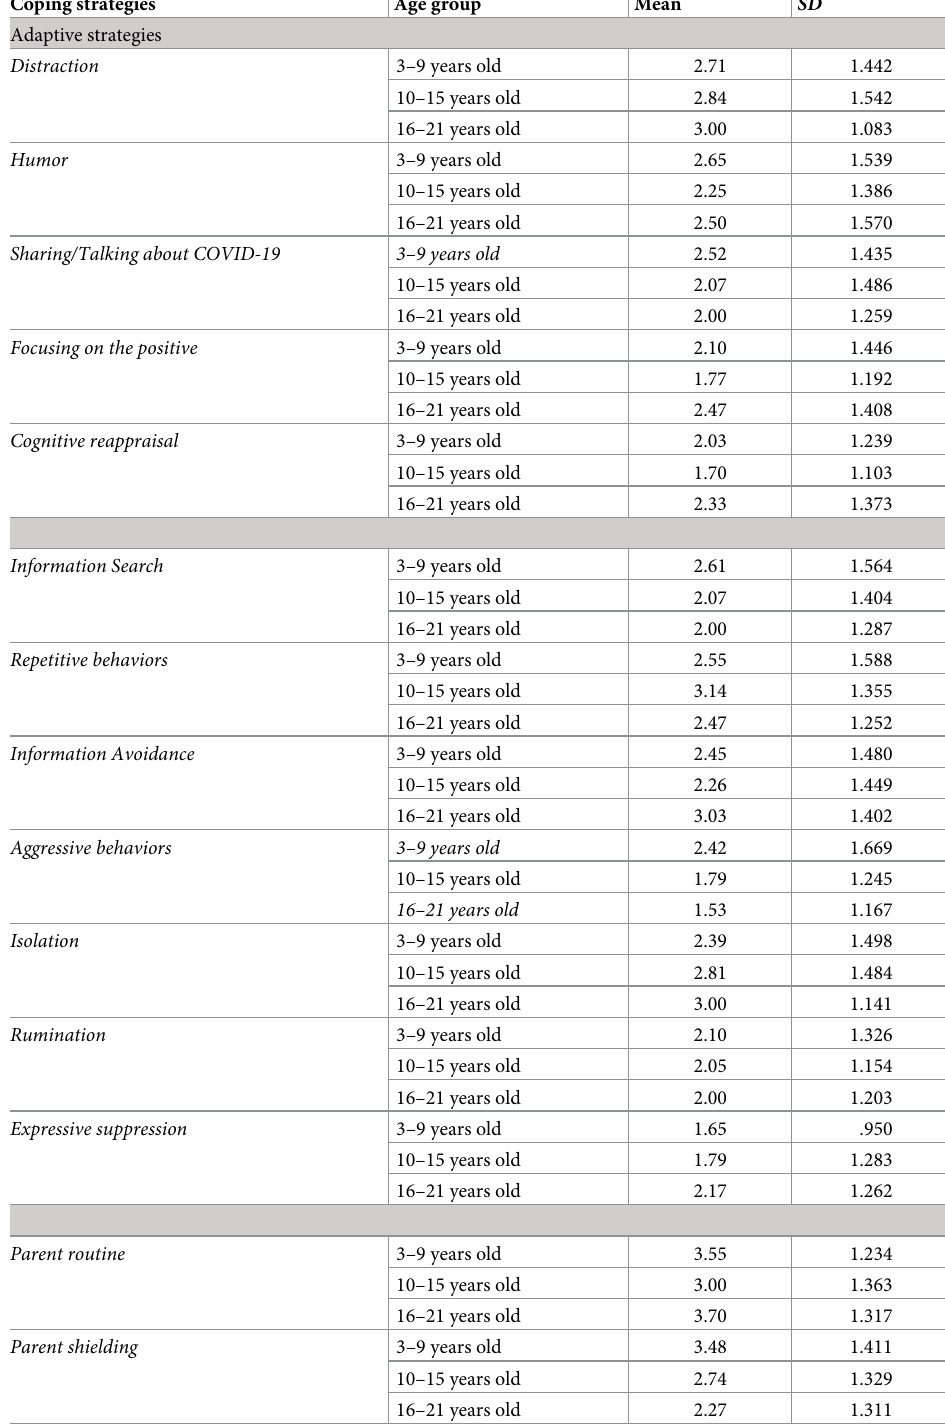
Table 6. Efficacy of coping strategies across age